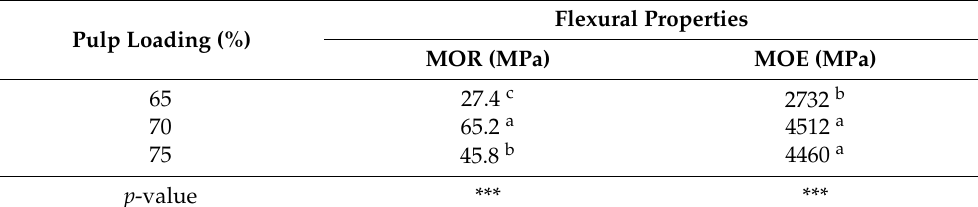
Table 9. Summary of the least significant difference (LSD) test results for the different pulp loadings based on the flexural properties of the